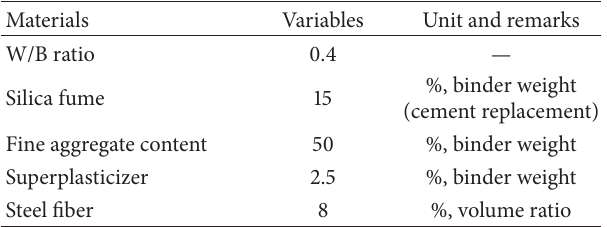
Table 3: Experimental variables in slurry mix